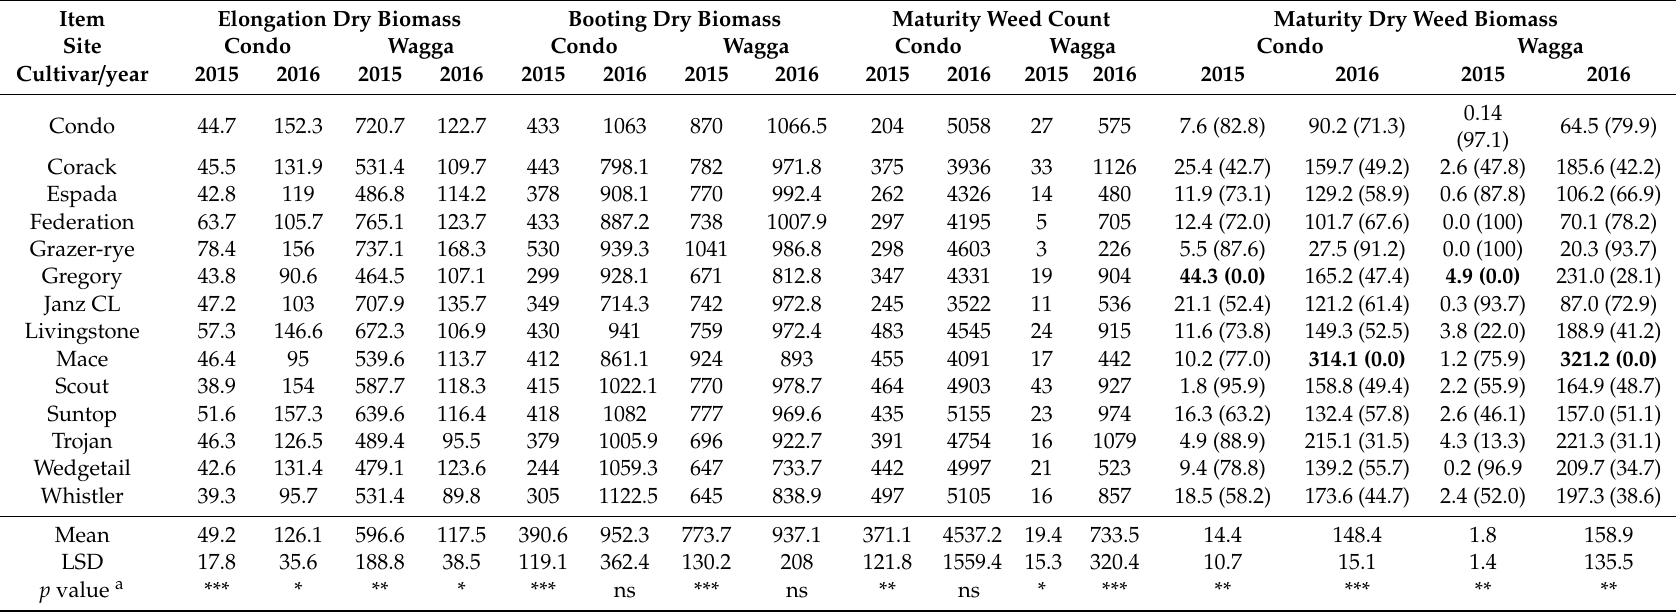
Table 4. Wheat cultivar di ff erences in average crop biomass (g / m 2 ) at crop elongation and booting growth stages, in-crop weed count (plants / m 2 ), and weed dry biomass (g / m 2 ) at crop maturity (including weed suppression percentage in the brackets expressed in comparison to the less suppressive cultivar in the same year and location) at Condobolin and Wagga in 2015 and 2016. Each data value is a mean of six